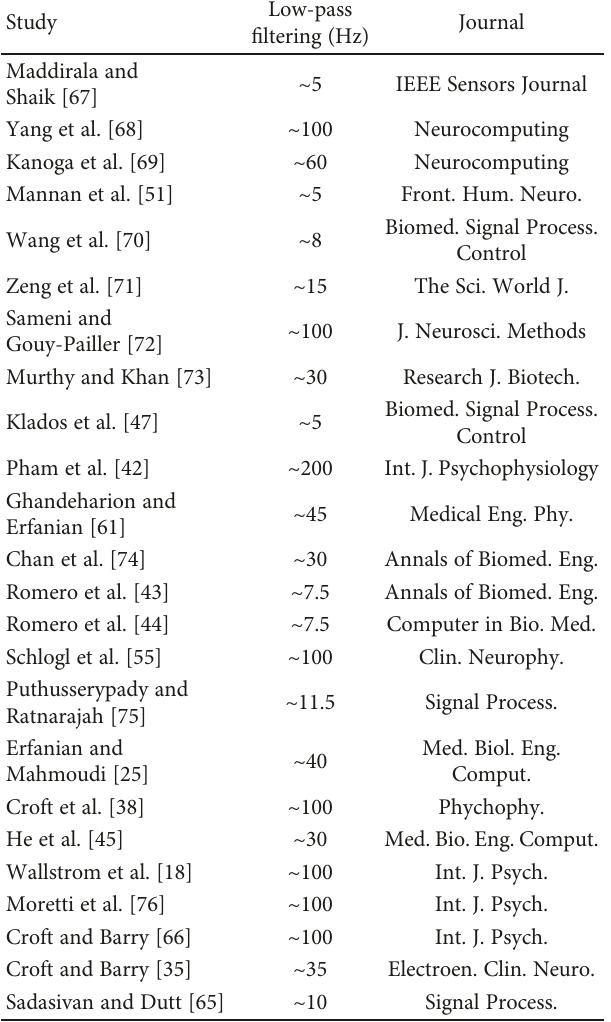
Table 1: Di ff erent low-pass EOG signal fi ltering frequencies used in